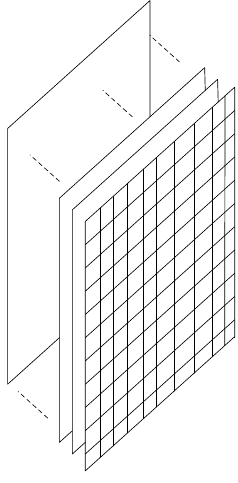
Figure 2. Two-dimensional matrices of the same size.